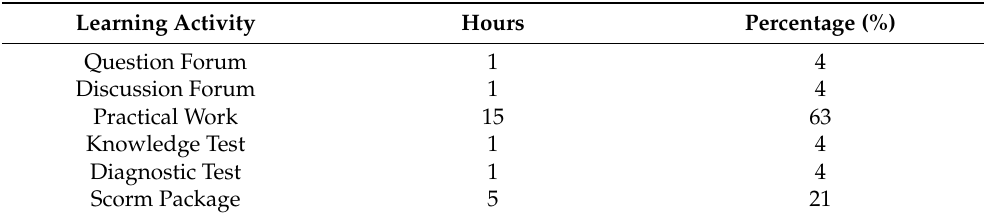
Table 5. Distribution of the estimated duration for the different learning activities on the Open Biotec